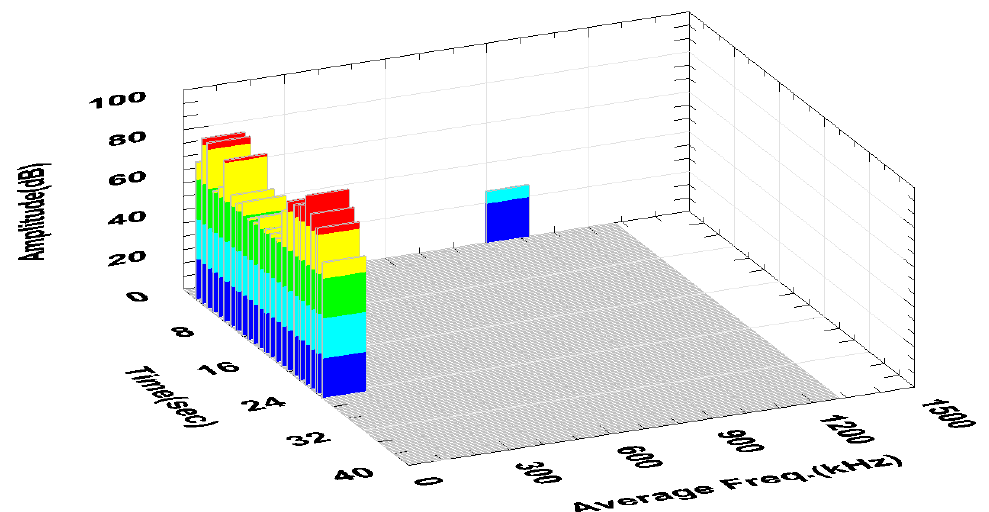
Figure 16. Chart of amplitude and average frequency changing as a function of time, during turning with parameters: ap = 2.0 mm, f = 0.05 mm/rev. Different colours help to observe changes in amplitude-every 20 dB.